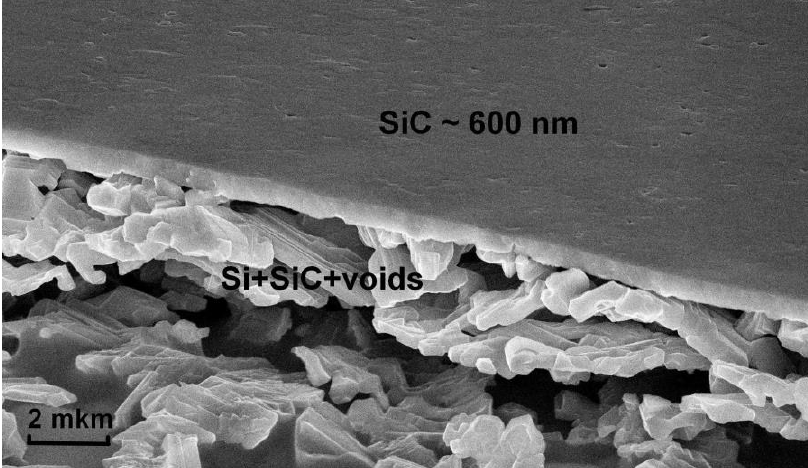
Figure 4. SEM image of a section of a 3C-SiC/Si(111) sample produced at t a = 25 min and starting to delaminate from the substrate. delaminate from the